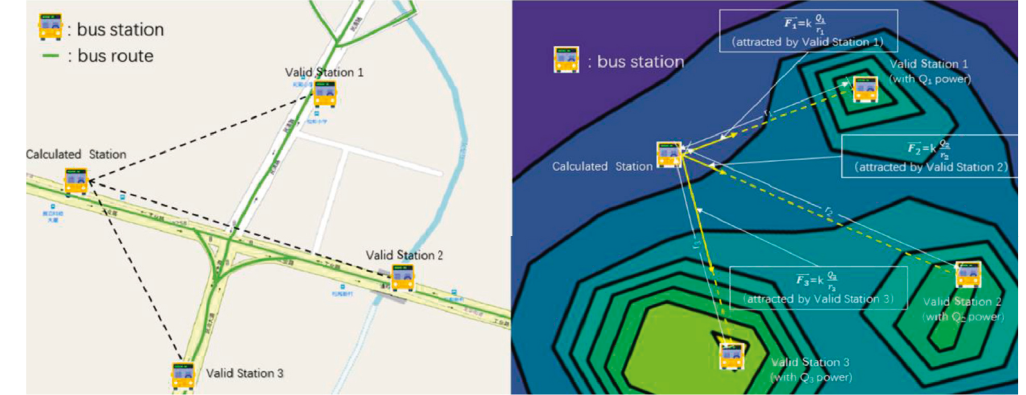
Figure 2: Force analysis in equipotential